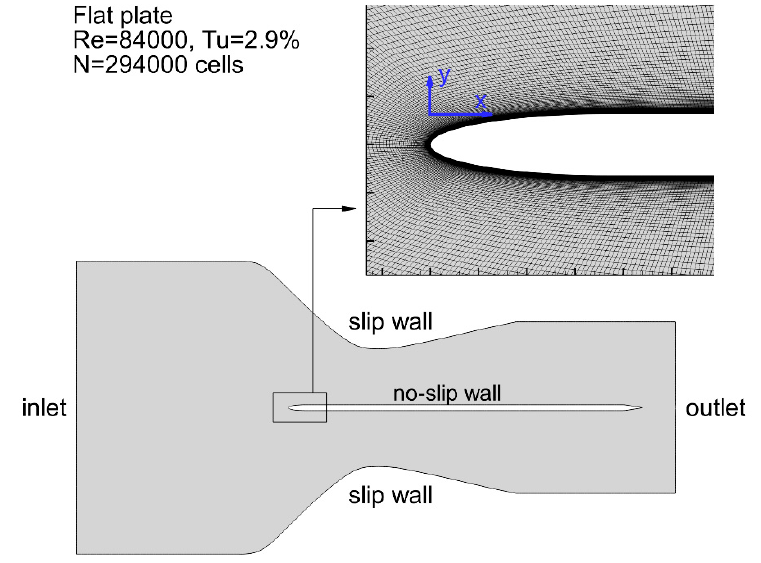
Figure 7. Flat plate by Li and Yang. Computational domain, boundary conditions and grid details close to the plate leading edge.